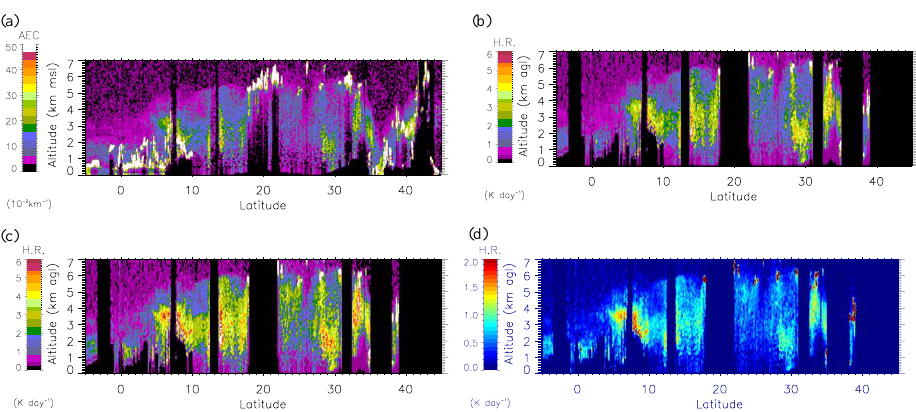
Fig. 13. (a) Aerosol extinction coefficient profiles derived from the CALIOP lidar on 14 June at 13:20 UTC. Heating rate derived using the RaCH model (b) and the CHOM model (c) . (d) The difference between the two heating rate fields shown in (b) and (c).